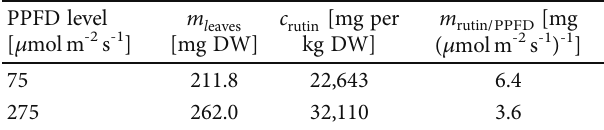
Table 3: Results for the PPFD speci fi c rutin amounts based on the mean values of the levels of light intensity, the mass of leaves harvested (DW: dry weight), and the concentrations of rutin